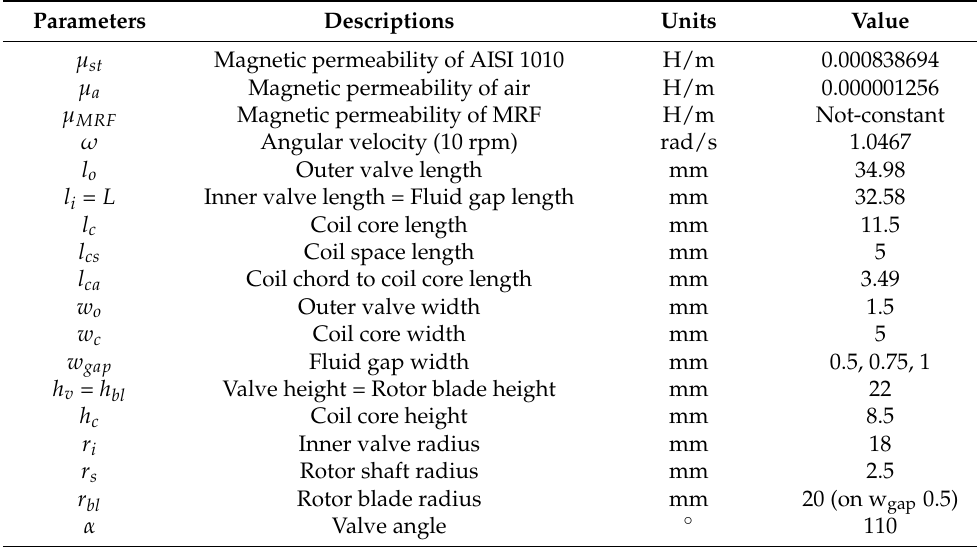
Table 3. Complete parameters of static valve